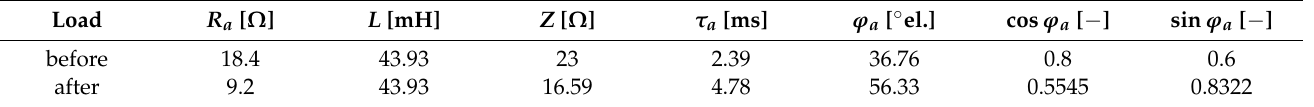
Table 40. Load parameters for steady states before and after load change.